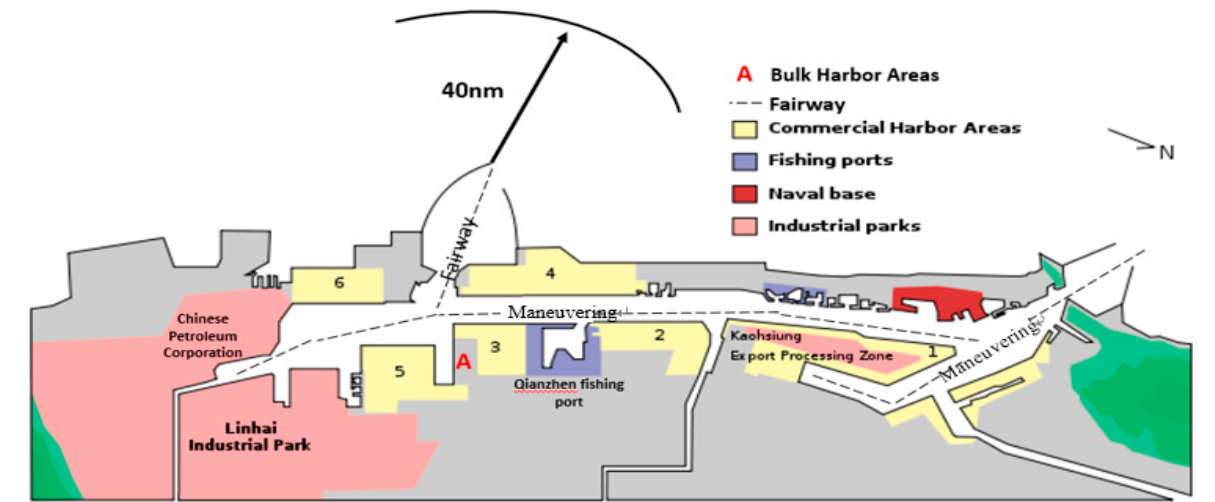
Figure 1. Location of the terminals in the Port of Kaohsiung.